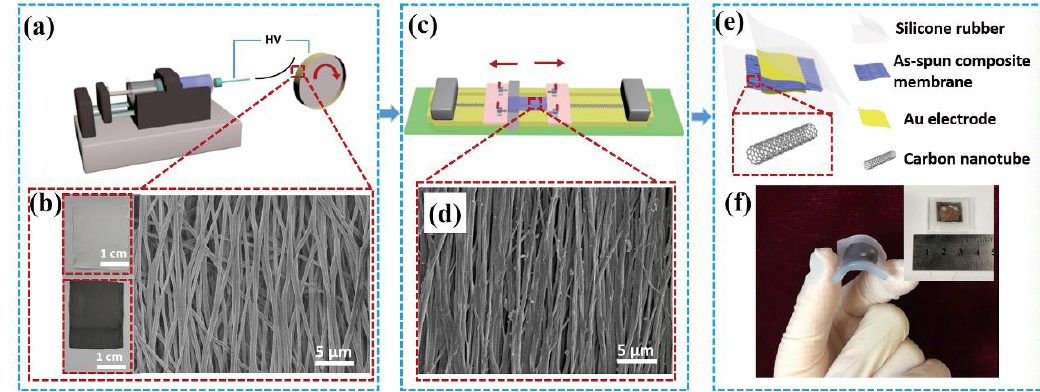
Figure 1. Overview of the piezoelectric pressure sensor. ( a ) Schematic diagram showing the experimental setup for fabrication of PVDF-TrFE/MWCNTs nanofibers. ( b ) Image of electrospun PVDF-TrFE (upper left) and PVDF-TrFE/MWCNTs nanofibers (lower left) and SEM micrograph of the electrospun composites nanofibers (right). ( c ) Schematic diagram of the mechanical drawing experimental setup. ( d ) SEM micrograph of the stretched composites nanofibers. ( e ) Schematic drawings showing the structure and flexibility of the sensor. ( f ) A flexible sensor sample and inset showing the front of the sensor.